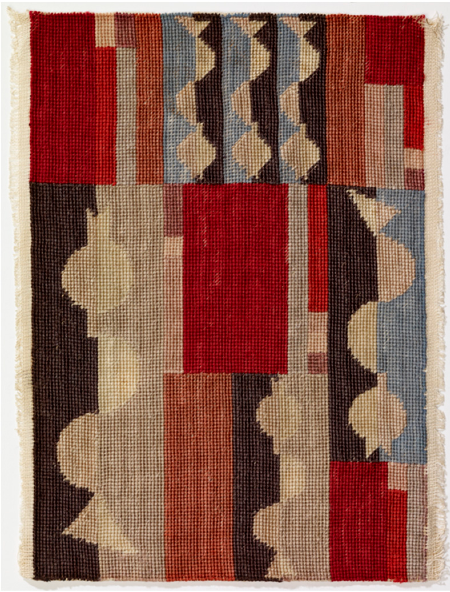
Figure 13. Sophie Taeuber-Arp, Composition à motifs d’oiseaux, ca. 1927–1928. Petit-point embroidery, wool on linen ground. 25 cm × 35.5 cm. Private collection, used by permission.